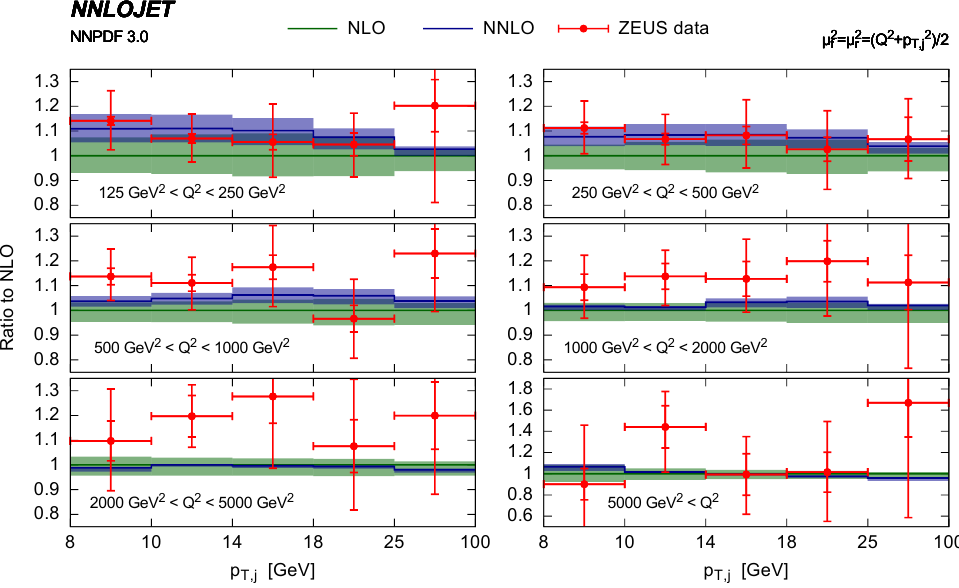
Figure 6 . Inclusive jet production cross section as a function of the jet transverse momentum p T;B in bins of Q 2 , compared to ZEUS